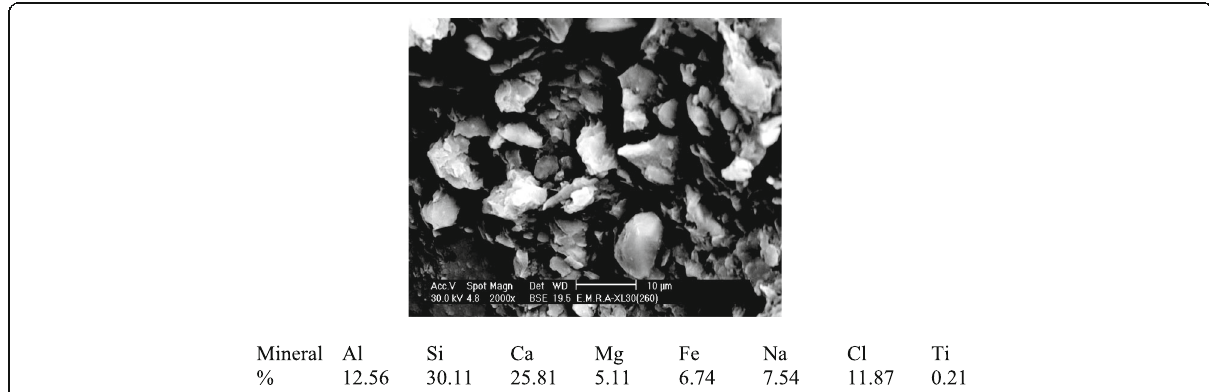
Fig. 5 SEM photomicrograph showing authigenic and detrital montmorillonite with ragged illite flakes, with face to face orientation (montmorillonite occurs as wavy sheets)